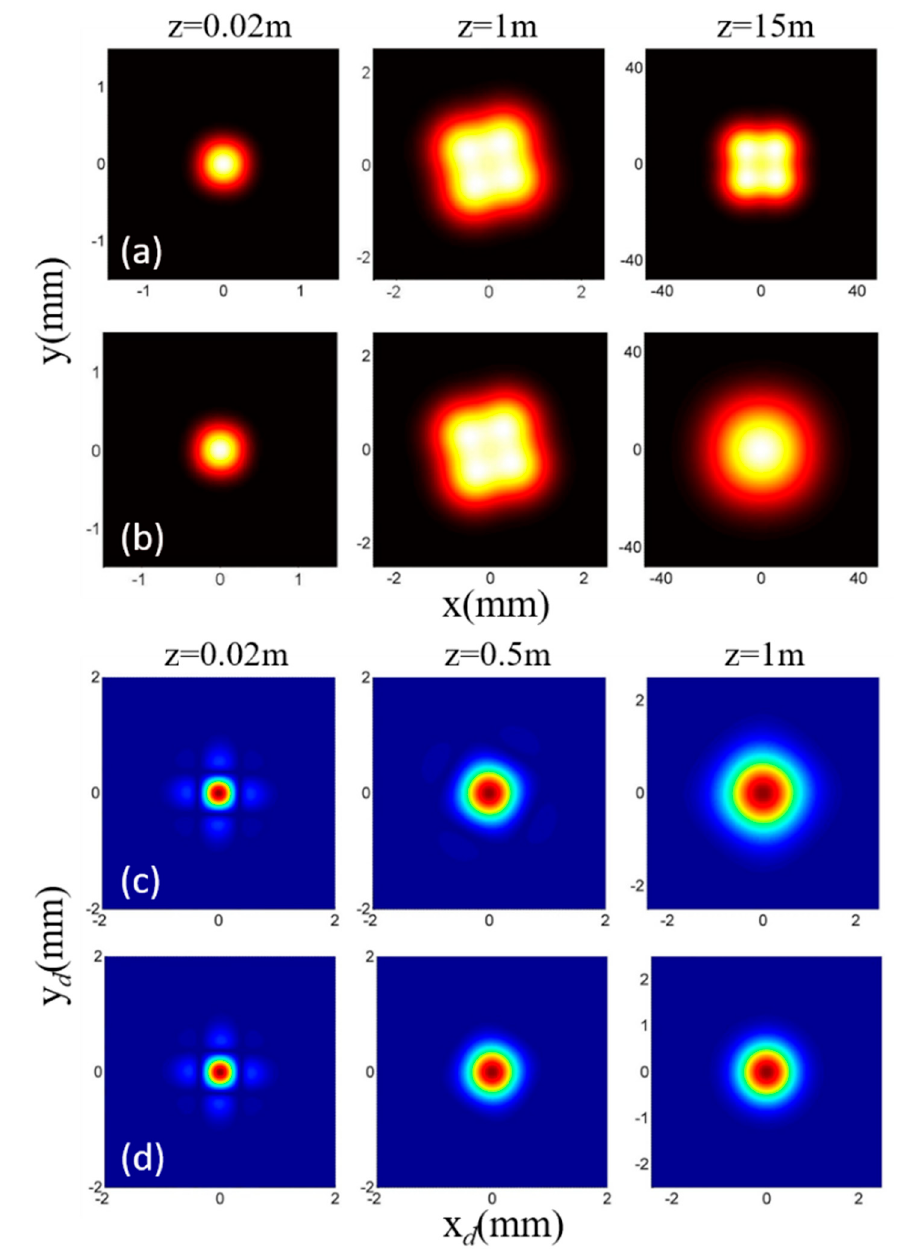
Figure 2. The ( a , b ) spectral density and (c, d) DOC generated by a Twisted Rectangular Multi- Gaussian Schell-Model (TRMGSM) source in ( a , c ) free space and ( b , d ) oceanic turbulence during propagation.